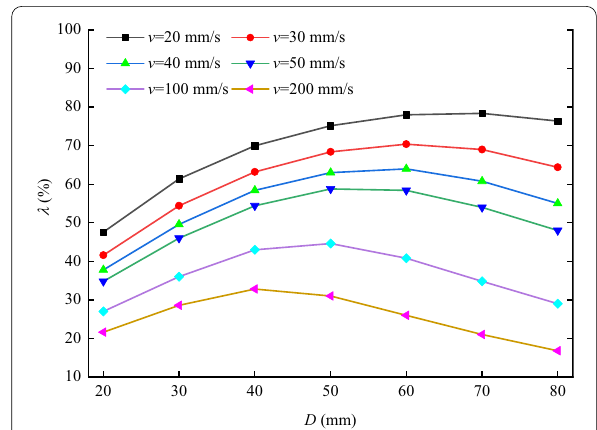
Figure 7 The influence curve of the sampling tube diameter on the coring rate